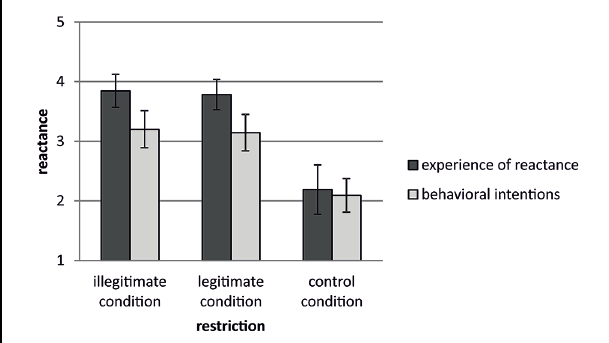
FIGURE 1 | Experience of reactance and behavioral intentions in the three experimental